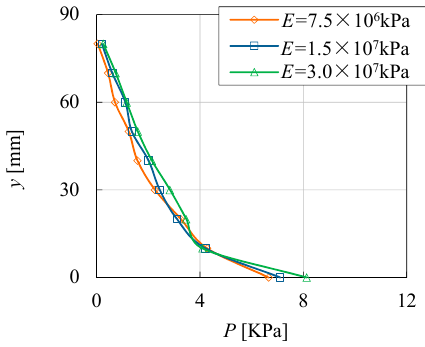
Figure 12. Vertical distribution of wave pressure on the structure under different structure stiffness.